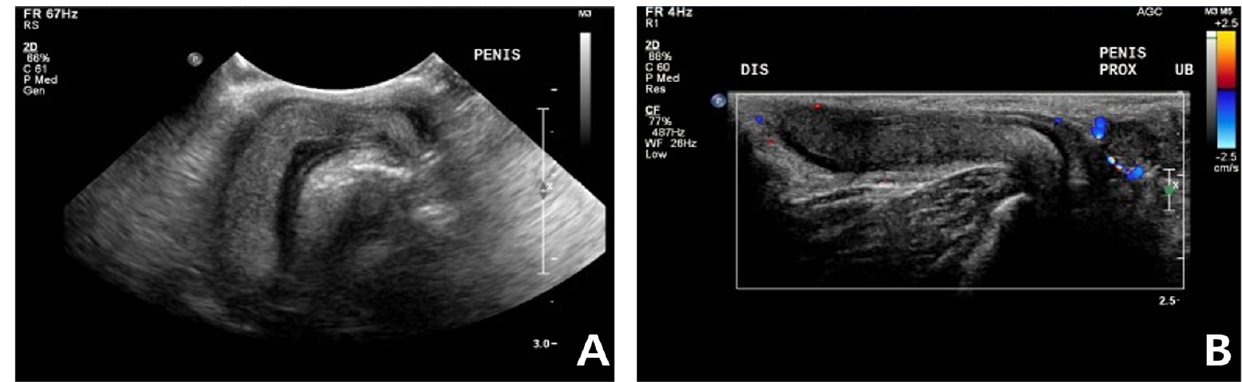
Figure 3. Ultrasonography in a cat with non-ischemic priapism ( A ) swollen penis with homogeneous parenchyma; ( B ) The color-flow Doppler examination did not clearly identify penile cavernosal artery blood flow due to the small size of the feline penis.